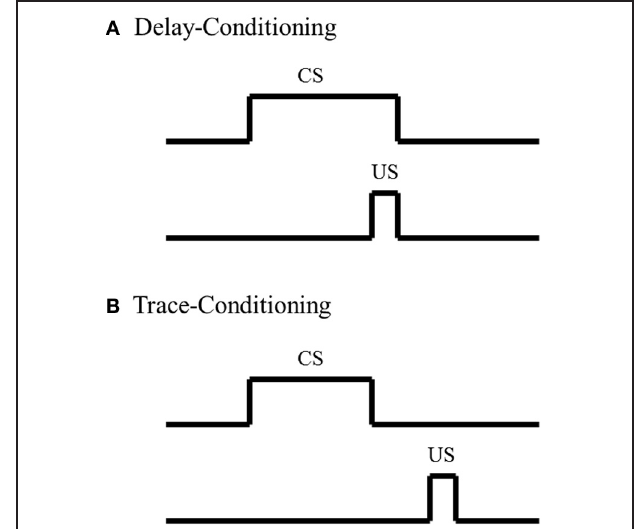
FIGURE 1 | Schematic of Pavlovian conditioning paradigms. (A) In delay-conditioning, the conditioned stimulus (CS) (e.g., tone, whisker stimulation) co-terminates with the unconditioned stimulus (US) (e.g., mild footshock, eye shock). (B) In trace-conditioning, there is a stimulus-free separation in time between the CS and